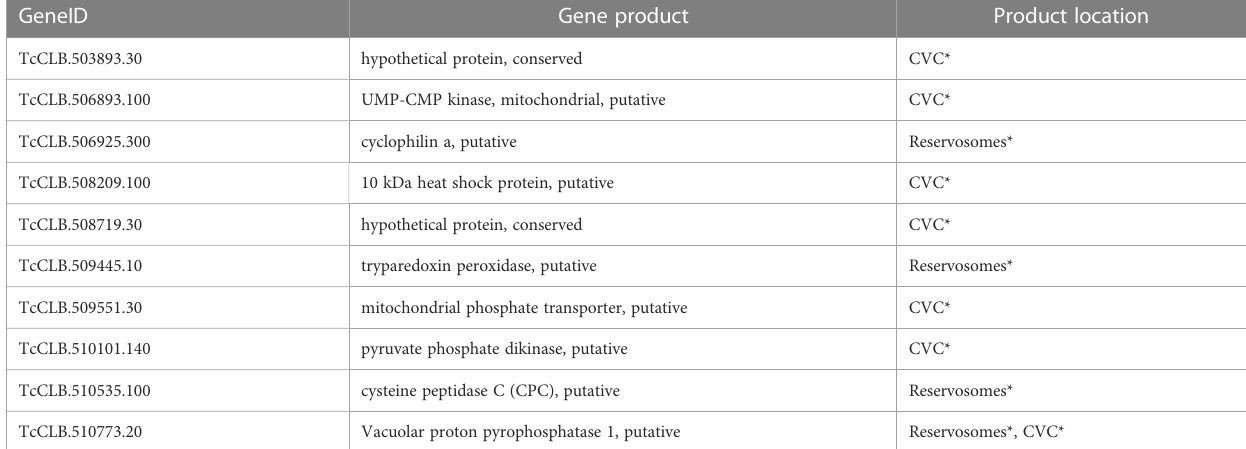
TABLE 2 Downregulated Se ⋂ Si DEGs in the enriched categories including vacuole and vesicle terms.